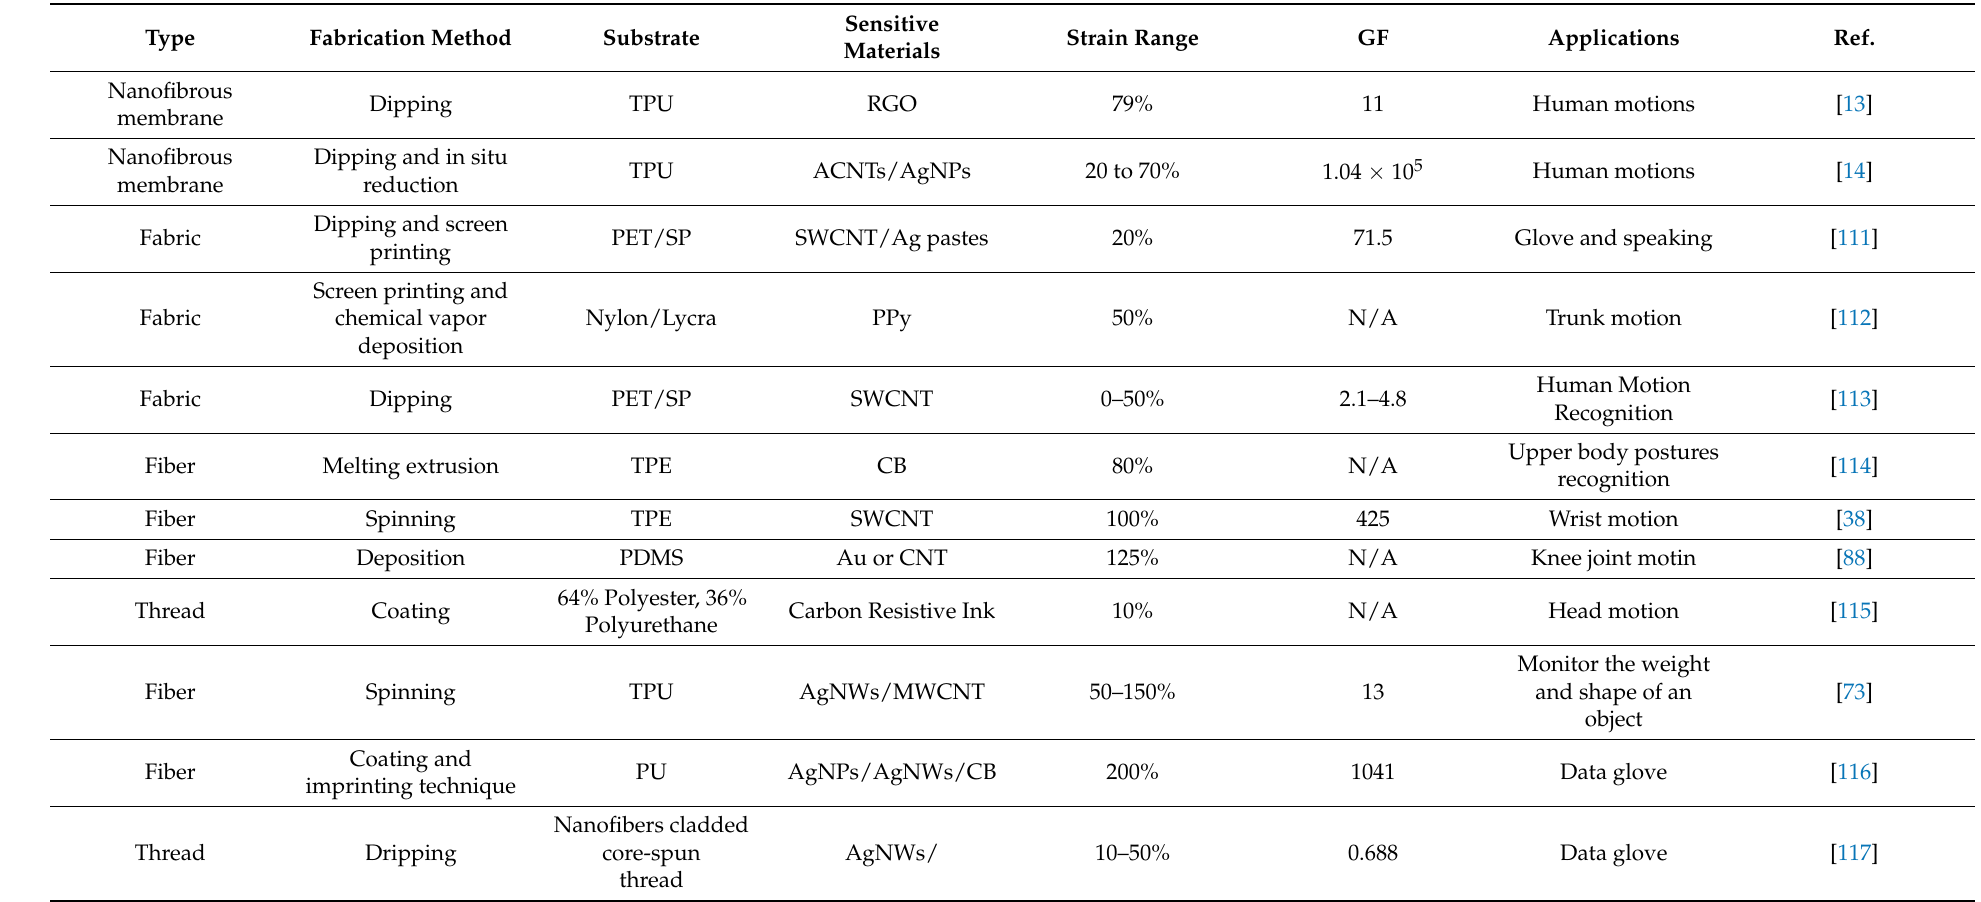
Table 8. Representative properties of different resistive strain